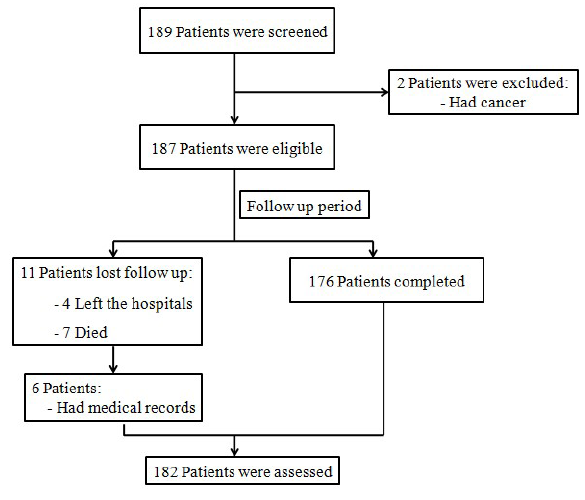
Figure 1. Enrollment and follow-up of patients in the